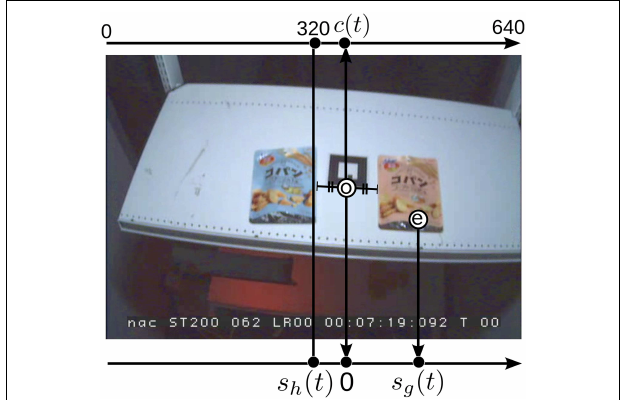
FIGURE 3 | Definition of head center s h ( t ) and gaze s g ( t ) in the head-mounted camera’s view: The item center o is semi-manually tracked and c ( t ) is calculated on the axis that starts from the left edge (shown on the top of the image). Then, s h ( t ) and s g ( t ) are defined by the coordinate axis shown at the bottom of the image where c ( t ) was set as the origin. The circled e is the gaze point reported by the eye tracker. Note that the sign of s h ( t ) is positive when the head is oriented to right and negative for the left orientation.